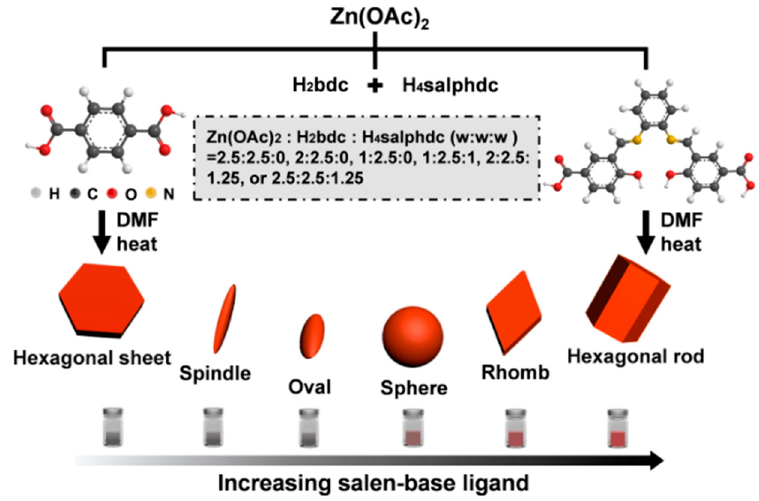
Figure 17. Morphology-selective formation of Zn-based coordination polymer particles with Zn 2+ , H 2 bdc, and/or salen linkers. [86].